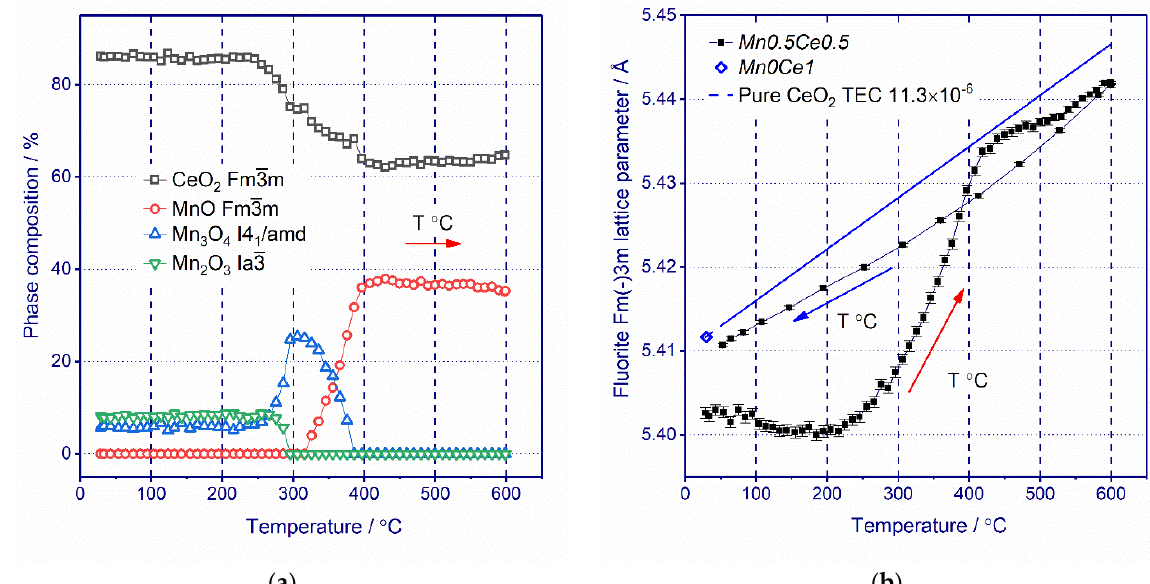
Figure 7. Changes in the fluorite cell parameter ( a ) and phase composition ( b ) during in situ reduction treatment under hydrogen for Mn0.45Ce0.55 catalyst. The cell parameter a (blue diamond) for the as-prepared Mn0Ce1 catalyst and its changes with temperature (blue dash line) considering TEC (α = 11.3 10 −6 K −1 [41] is shown for comparison purposes).